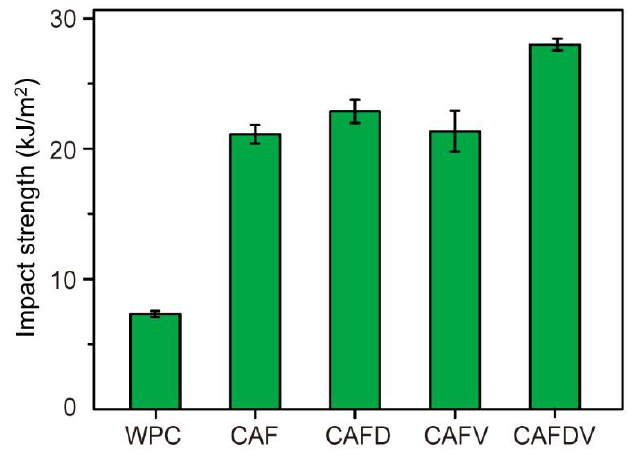
Figure 10. Impact strength of the CAF reinforced WPCs.